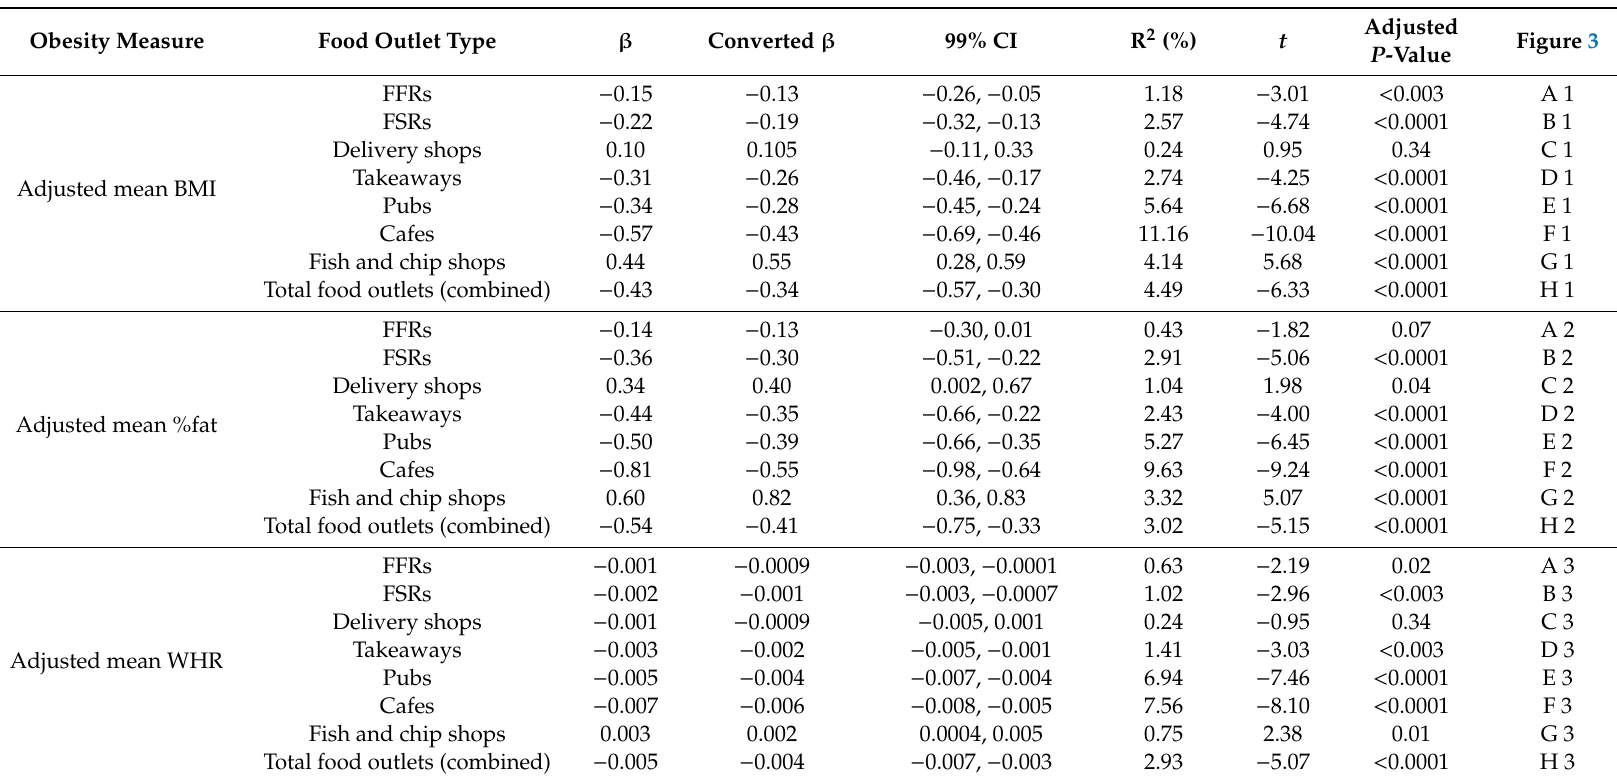
Table 6. Males: Linear regression analysis of the association between log-transformed numbers of food outlets per 1000 population and adjusted obesity measures. Obesity Measure